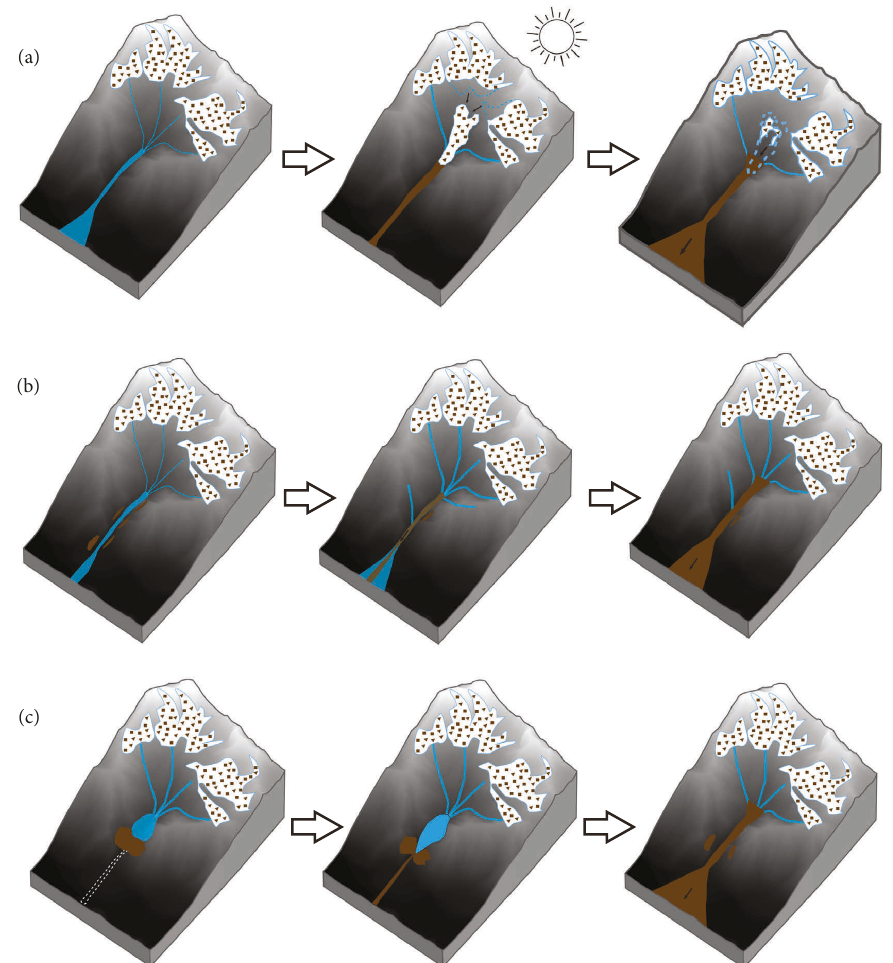
Figure 6: Formation mechanisms of debris flow along the Parlung River. (a) Mode I, (b) mode II, and (c) mode